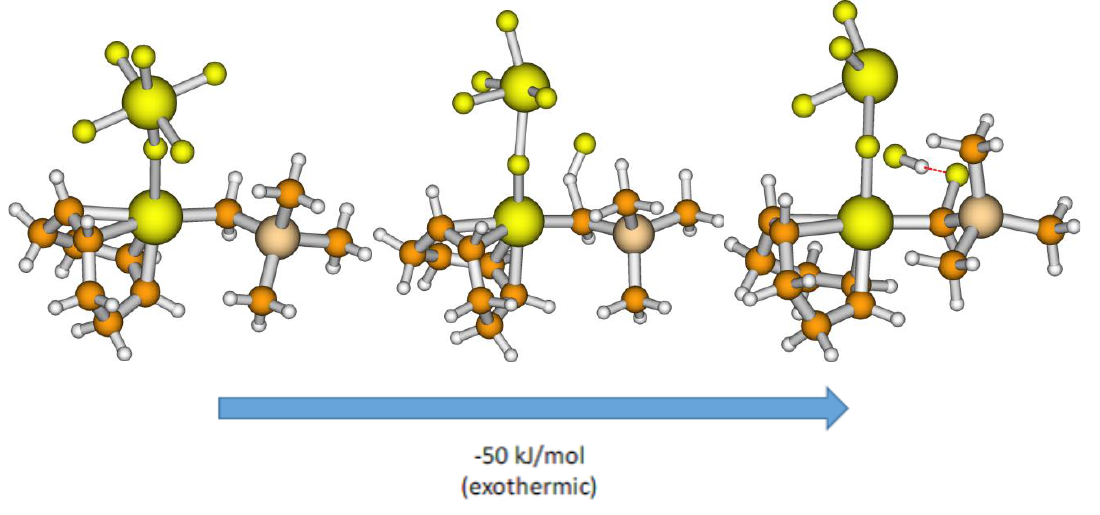
Figure 4: DFT calculated [Pt(cod)(neoSi)] + … SbF 6 – adduct with Pt … F ‒ Sb bonding (left) and its decomposition product (right) via an intermediate state (middle) as calculated in acetone solution.